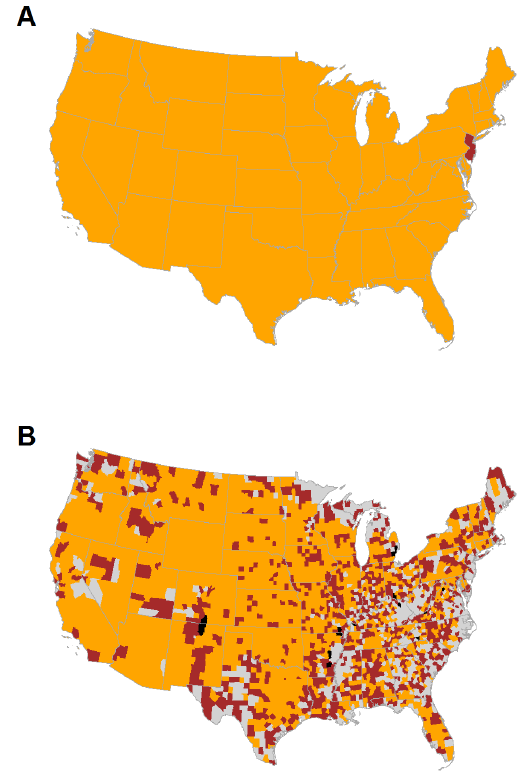
Figure 2. The giant strongly connected component (GSCC) of the network from a 10% sample of ICVIs. Maps at the (A) state and (B) county scales. Orange denotes a node in the GSCC. Brown denotes a node outside of the GSCC that either sends to or receives from nodes in the GSCC but not both, and black indicates nodes that are isolated from the GSCC. Gray indicates no data. New Jersey is outside the state level GSCC because it was the only state not to supply ICVI data.